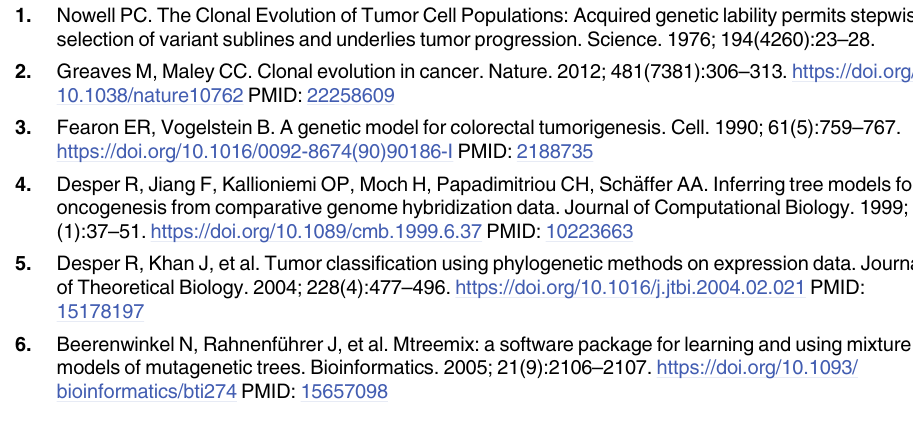
S1 Table. Driver genes for luminal breast cancer. Genes selected by CancerMapp pipeline that showed significant changes along the progression of gene expression profiles. S2 Table. Pseudo-time analysis for mutations and patients. Maximum likelihood estimation of the accumulation orders and conditional expectation of progression times for all unique